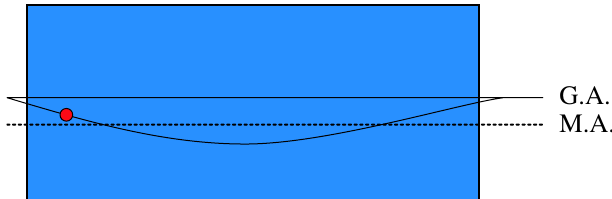
FIG. 2. (Color) Beam trajectory in a semiperiod of the magnet. The geometric (G.A.) and the magnetic (M.A.) axes of the wiggler are separated. In this case the particle is at the left of the magnetic axis.